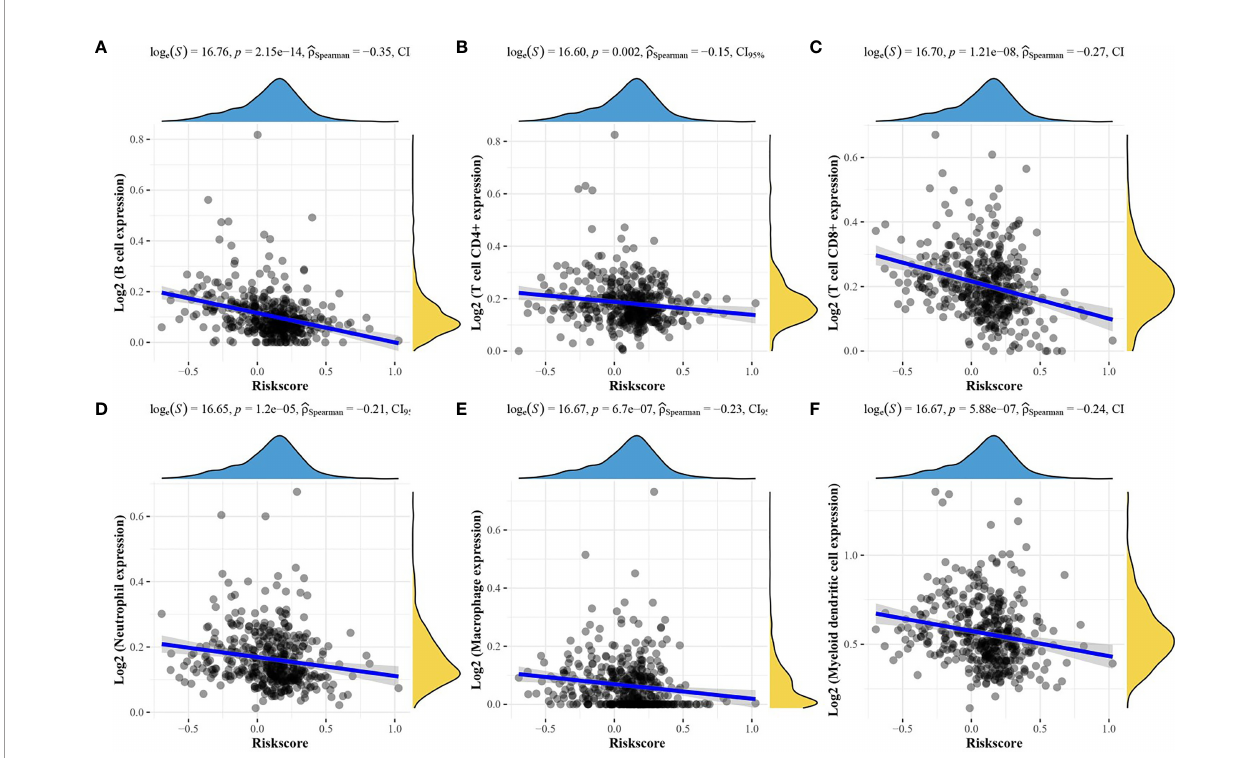
FIGURE 8 | Relationship between the risk score model and the abundance of the six immune in fi ltrating cells. (A) B cells; (B) CD4+ T cells; (C) CD8+ T cells; (D) neutrophils; (E) Macrophages, (F) Myeloid dendritic cells.